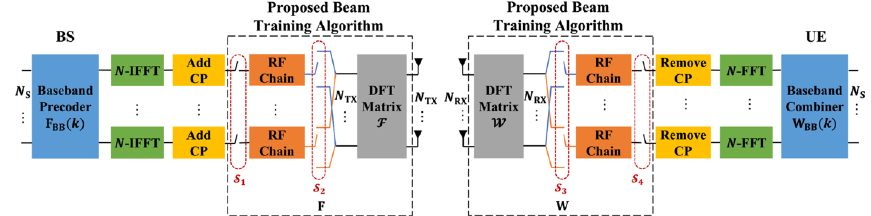
Fig. 2 The fully connected hybrid beamforming architecture for a MIMO-OFDM